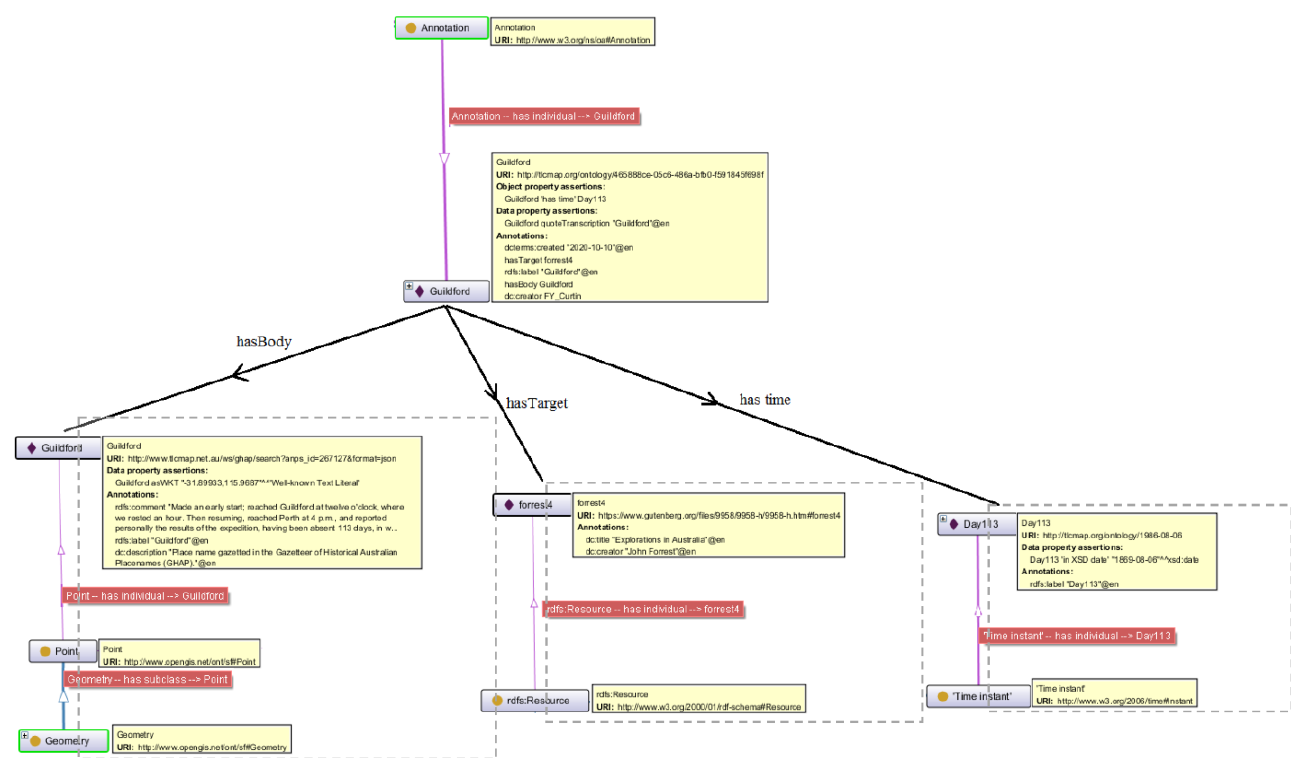
Figure 9. Convert location and time data into RDF format.